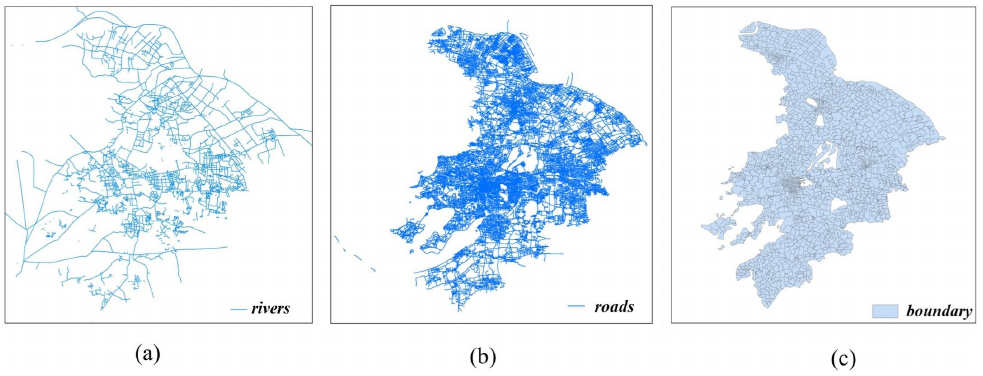
Figure 6. The original vector geographic data: ( a ) rivers; ( b ) roads; ( c ) boundary. Table 1. Detail of the experimental data.